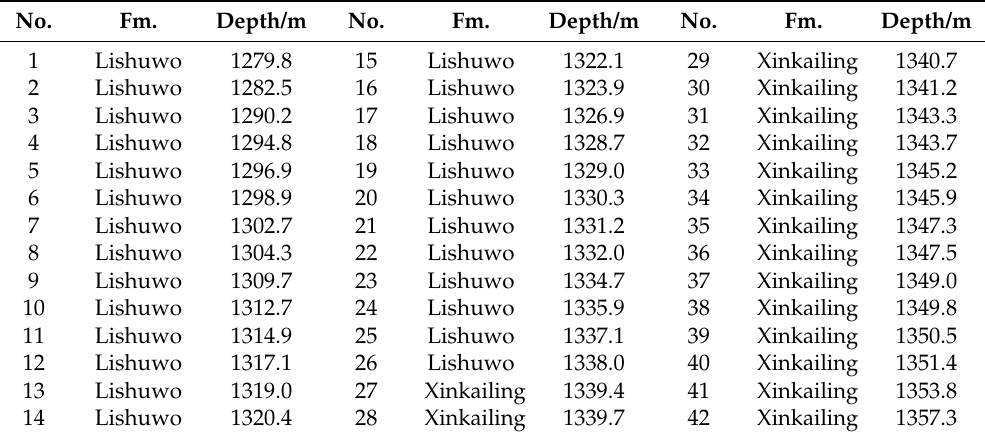
Table 1. The sample numbers, formations and burial depths of the samples from Well X for total organic carbon (TOC) tests. See Figure 1 for the well